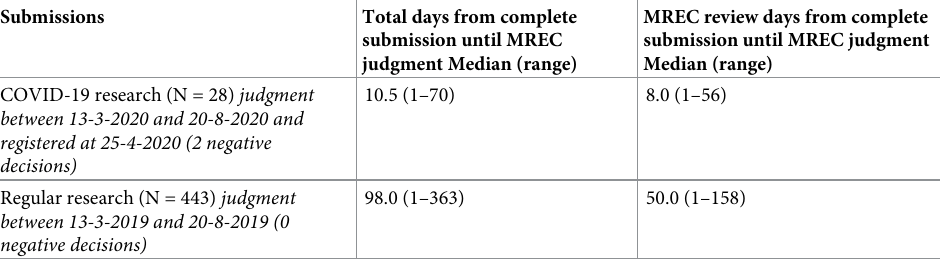
Table 4. Review times for COVID-19 research and regular research (based on data from national registration sys- tem CCMO).